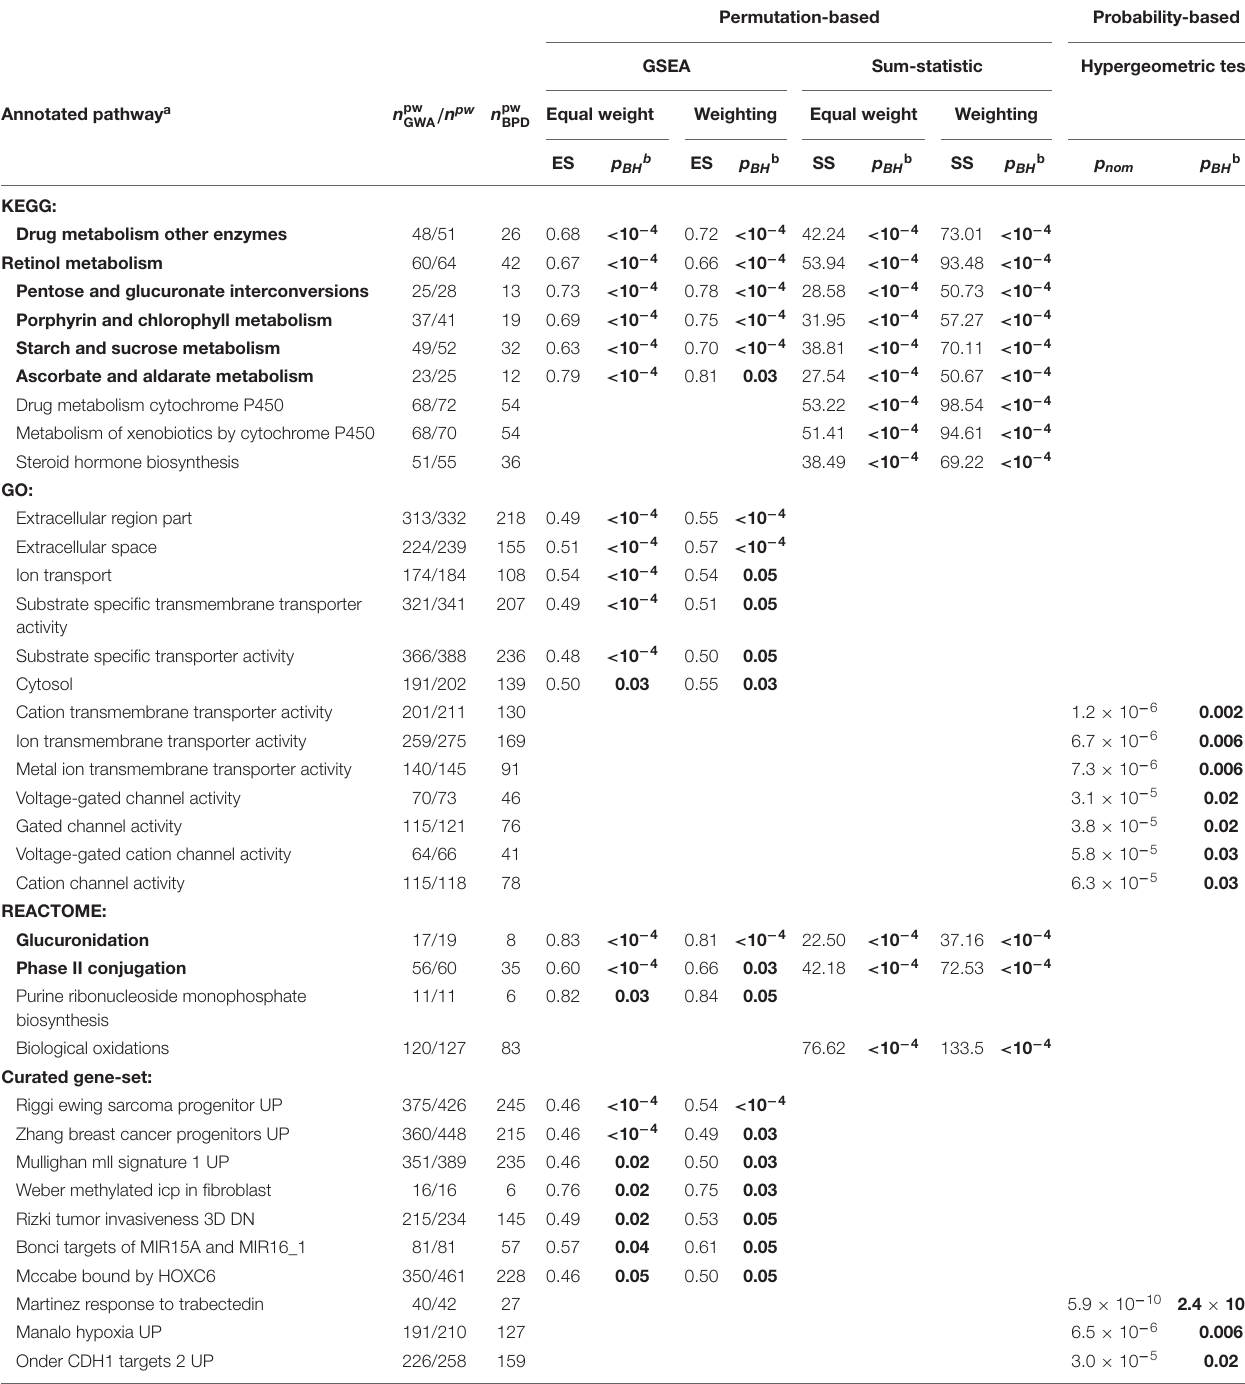
TABLE 1 | Significantly enriched pathways in the Genetic Association Information Network (GAIN) genome-wide association (GWA) study for bipolar disorder (BPD) using competitive and self-contained methods with and without weighting scheme. Permutation-based Probability-based GSEA Sum-statistic Hypergeometric